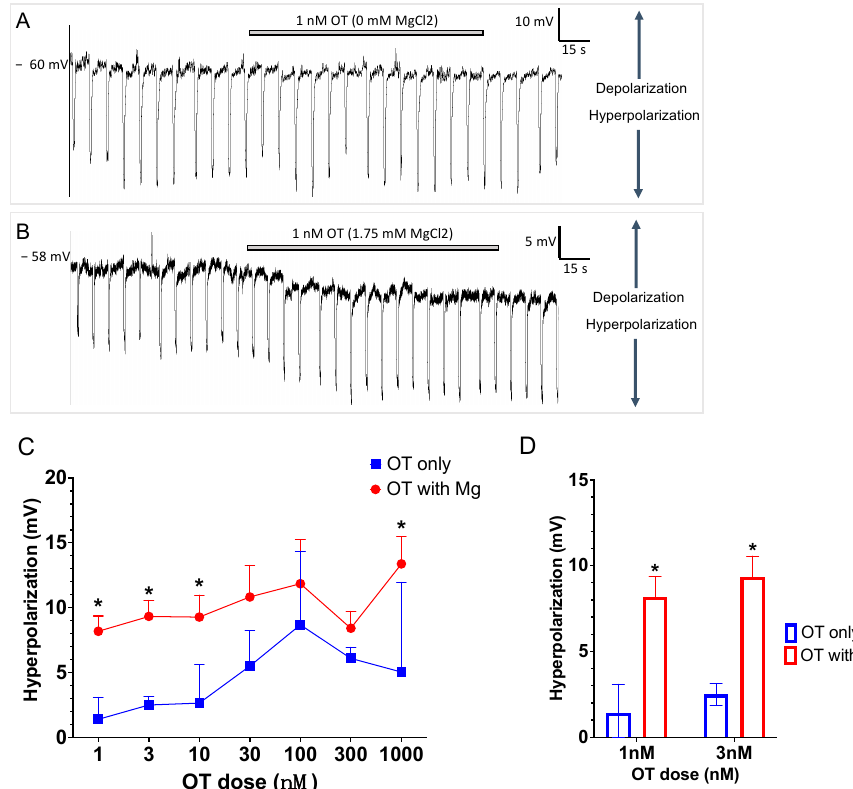
Figure 1. Effect of addition of Mg 2+ to the OT-induced decrease in excitability of TG neurons from CFA-inflamed rats. ( A , B ) Examples of current clamp traces of TG neurons from CFA-inflamed rat; ( A ) no change in membrane potential when treated with 3 nM OT in a 0 mM MgCl 2 buffer and ( B ) hyperpolarization observed when treated with 3 nM OT in a 1.75 mM MgCl 2 buffer. ( C , D ) OT alone dose-dependently hyperpolarizes TG cell membranes, decreasing excitability; the addition of 1.75 mM Mg 2+ significantly (* p < 0.05, ANOVA) potentiates the capacity of OT to hyperpolarize TG cell membranes ( C ). A specific example of this is observed in ( D ), where the addition of Mg 2+ significantly (* p < 0.05) increased the induced membrane hyperpolarization of 1 nM or 3 nM OT from − 1.4 ± 1.6 mV (n = 6) and − 2.5 ± 0.6 mV (n = 6) for OT alone to − 8.1 ± 1.2 mV (n = 7) and − 9.3 ± 1.2 mV (n = 7) for OT plus Mg 2+ , respectively. Subsequent pairwise comparisons indicated significant (* p < 0.05) differences from OT alone for OT plus Mg 2+ at 1, 3, 10, and 1000 nM OT concentrations. This enhanced hyperpolarization is emblematic of decreased excitability and thus, decreased capacity to carry pain signals to the central nervous system for pain perception. Error bars show ± S.D.